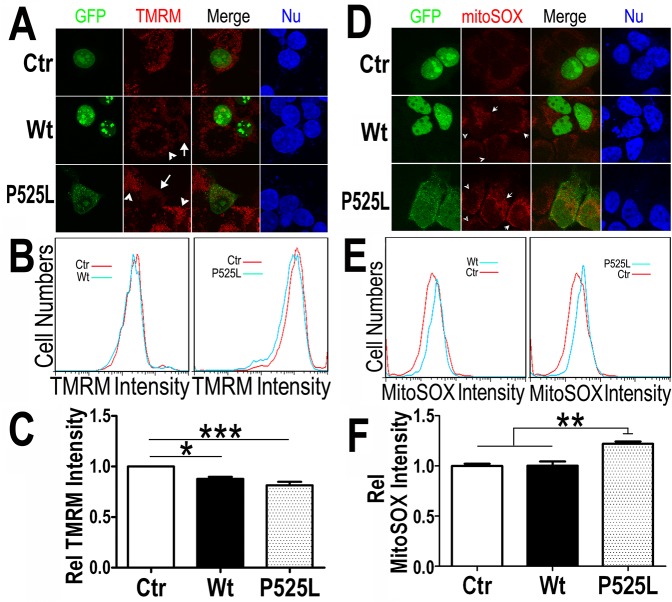
Increased expression of Wt- or P525L-mutant FUS induced a decrease in mitochondrial membrane potential and an increase in production of mitochondrial superoxide.(A) Confocal images of live TMRM-stained HEK293 cells following transfection with corresponding plasmids: the GFP control, Wt- or P525L-mutant FUS tagged with GFP. All images were acquired in Z-stacks and projected as single images. Cells were stained with TMRM (a mitochondrial membrane potentiometric dye) and Hoechst 33342 before imaging.(B, C)FACS analyses of GFP-positive cells from experiments in panel A with quantification of TMRM signal intensity. Cells expressing either Wt- or P525L-mutant FUS showed decreased TMRM intensity as compared with the control group. The data were analyzed using one-way ANOVA (representing 4 independent experiments; *: p< 0.05, ***: p< 0.001). (D) Confocal images of mitoSox Red-stained HEK293 cells 24-hrs following transfection as described in panel A and Hoechst 33342 staining. (E, F) FACS analyses and quantification of mitoSOX-Red stained cells shown in panel D. Cells expressing P525L-mutant FUS showed significantly increased mitoSOX staining signals as compared with cells expressing the control or Wt-FUS protein. Data from 3 independent experiments were analyzed using one-way ANOVA (**:p< 0.01).